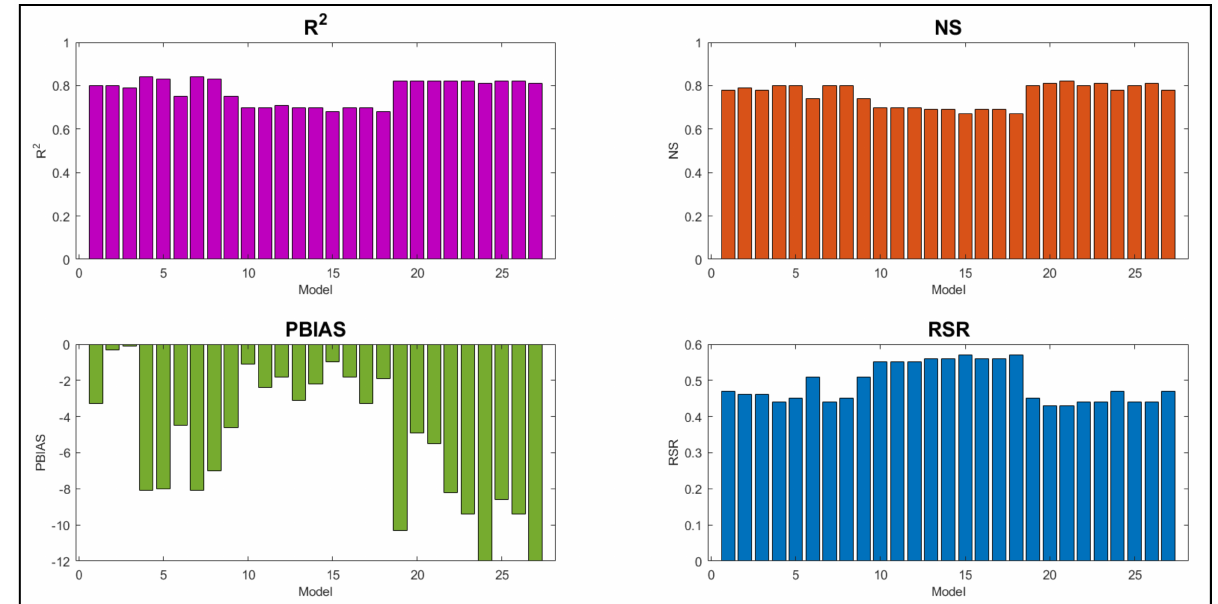
Figure 7. SWAT model performance for the 27 combinations shown with the four performance criteria (R 2 , NSE, PBIAS, and RSR) for the validation period. USGS